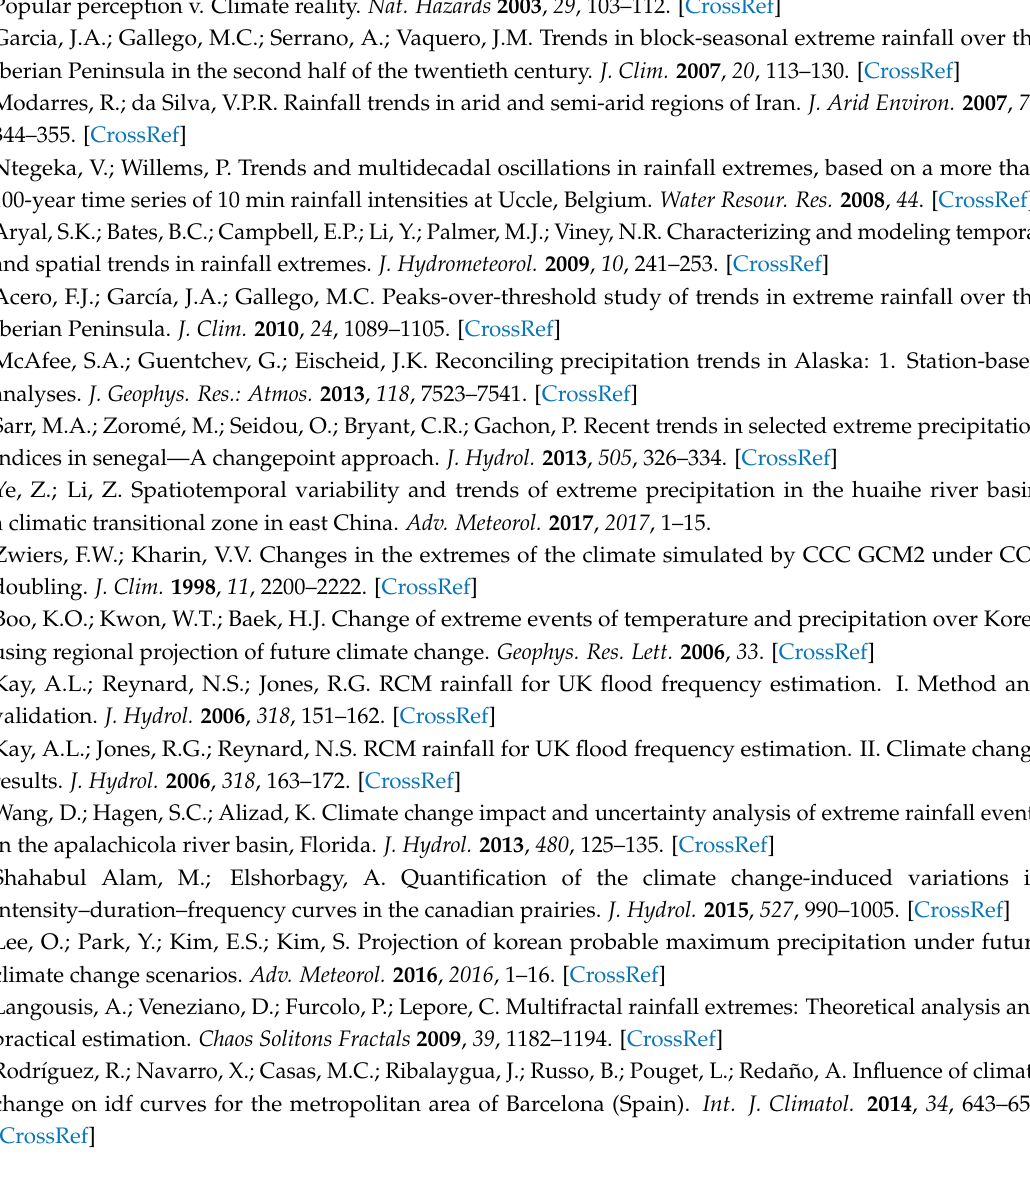
level, Figure S3: The BBS-MK test results of AM series on July for all employed durations at 5% significant level, Figure S4: The BBS-MK test results of AM series on August for all employed durations at 5% significant level, Figure S5: The BBS-MK test results of AM series on September for all employed durations at 5% significant level, Figure S6: The BBS-MK test results of AM series on October for all employed durations at 5% significant level, Table S1. Results of t-test between the scaling exponents for two of any employed